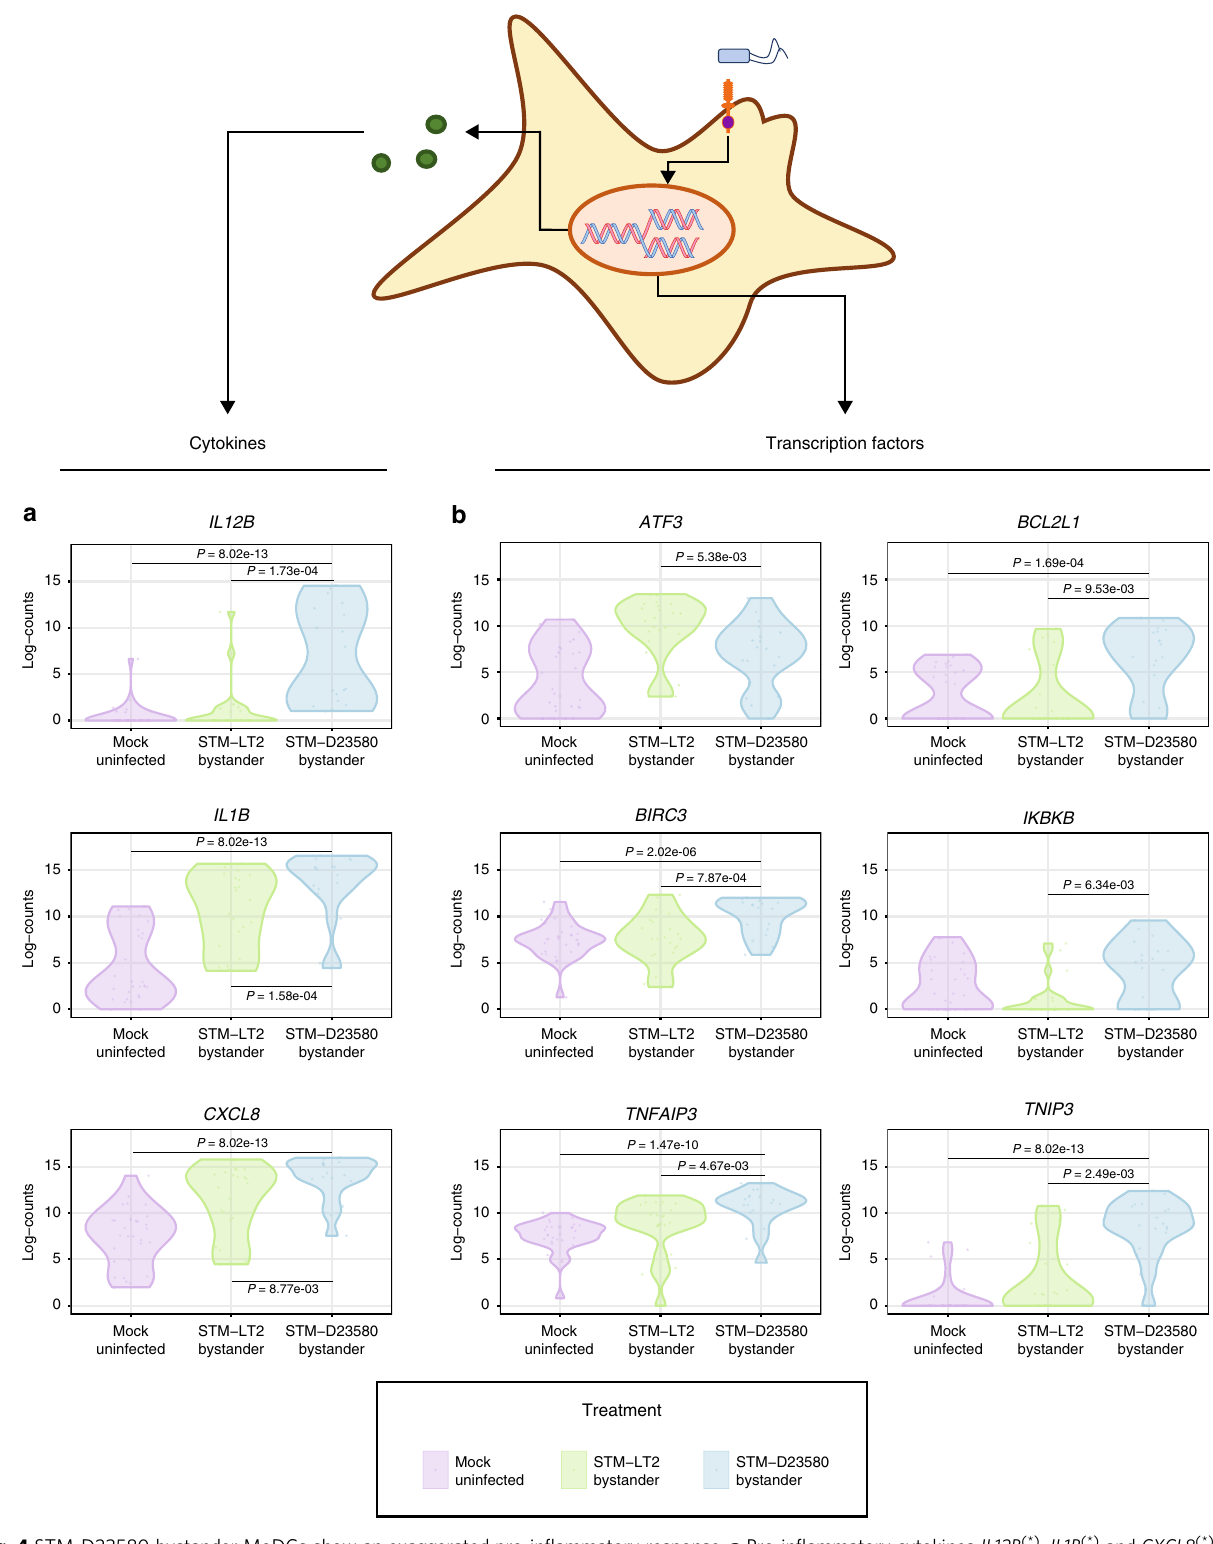
Fig. 4 STM-D23580 bystander MoDCs show an exaggerated pro-in fl ammatory response. a Pro-in fl ammatory cytokines IL12B (*) , IL1B (*) and CXCL8 (*) and b transcription factors BCL2L1 (*) , BIRC3 (*) , IKBKB (**) , TNIP3 (*) and TNFAIP3 (*) show signi fi cant ( P -value < 0.01) upregulation in STM-D23580 bystander cells compared to both STM-LT2 bystander MoDCs and uninfected control (*) or compared to STM-LT2 bystander MoDCs only (**) . ATF3 shows signi fi cant downregulation in STM-D23580 bystander cells compared to STM-LT2 bystander